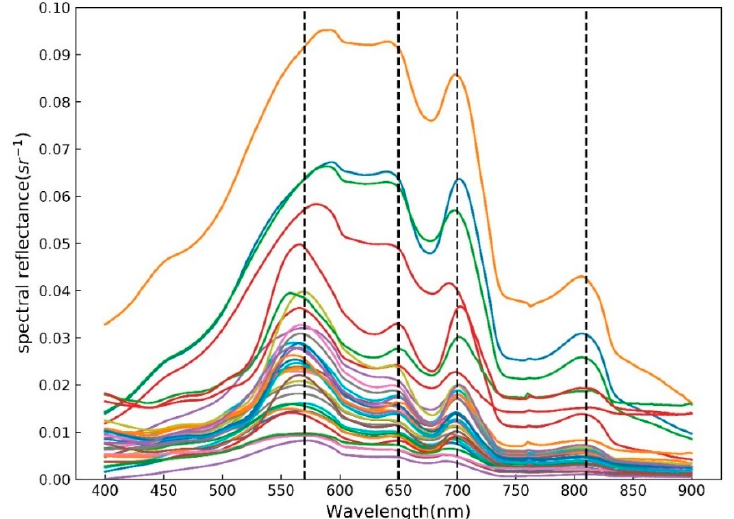
Figure 4. A number of 35 measured spectra of typical water collected by ASD in the 2015 cruise over ff erent color lines represent the di ff erent spectra of 35 water Hedi Reservoir, where the different color lines represent the different spectra of 35 water samples. Hedi Reservoir, where the di